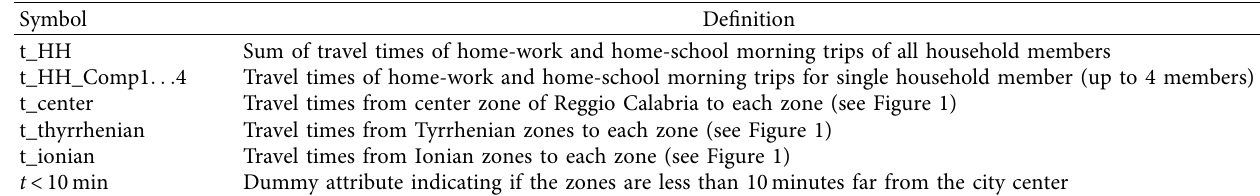
Table 2: Definitions of attributes of the proposed location models.